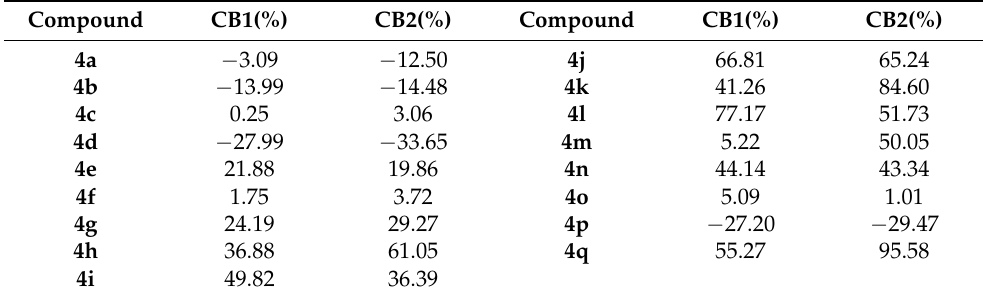
Table 1. Displacement of [ 3 H]CP-55,940 from CB1 and CB2 receptors by 10 µ M concentration of compounds 4a – 4q